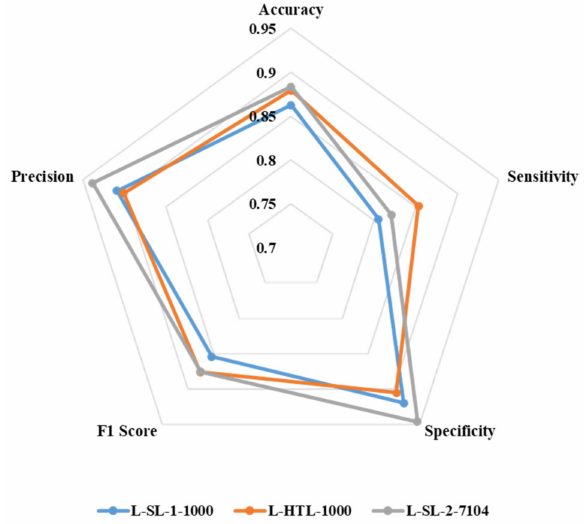
Figure 5. The radar chart is used to illustrate the accuracy, sensitivity, specificity, F1 score, and precision of L-SL-1-1000, L-HTL-1000, and